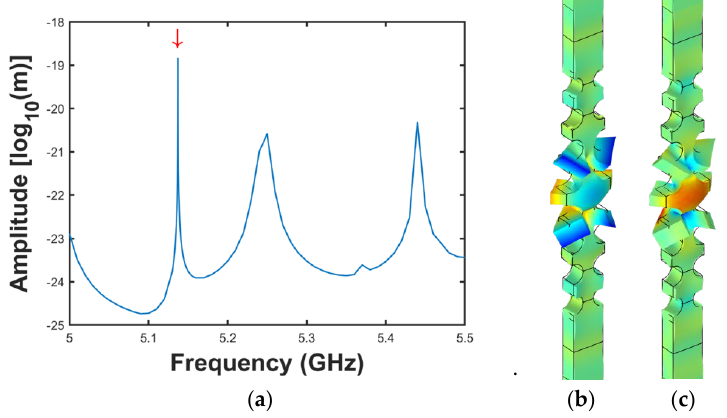
Figure 4. ( a ) The frequency spectrum of the type-III fishbone. The SS mode is marked by a red arrow. ( b ) The displacement field and ( c ) the strain field of the SS mode.